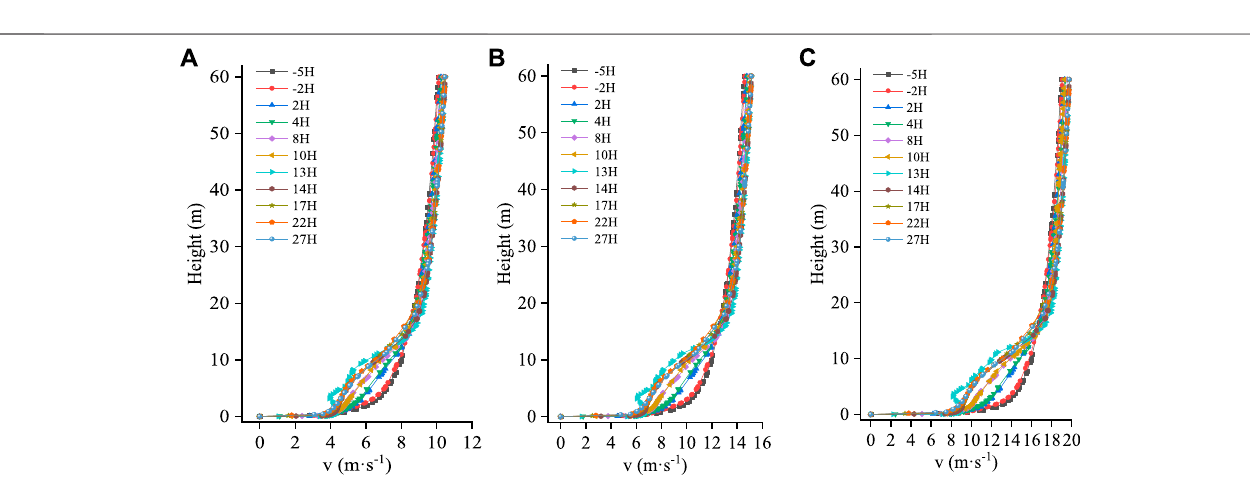
FIGURE 8 | Wind velocity pro fi le variations at different positions of three rows of windbreak forest belts under different incoming wind velocities. (A) :V = 8 m · s − 1 , (B) : V = 12 m · s − 1 , (C) : V = 16 m · s − 1 .